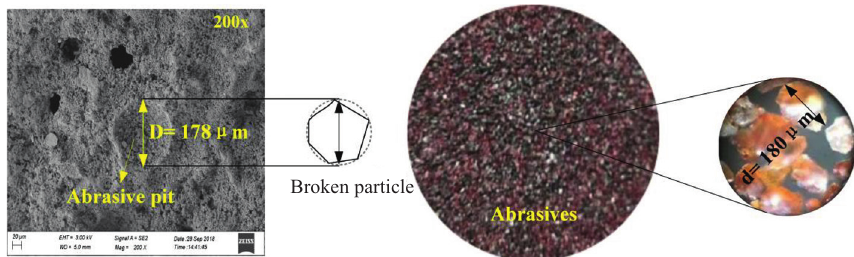
Figure 9: The magnitude order comparison of the abrasive pits and abrasive